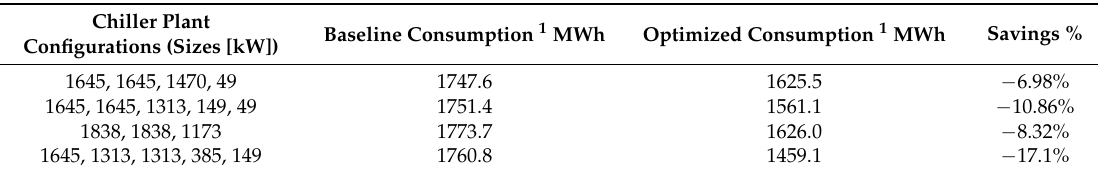
Table 2. Comparison of chiller energy consumptions and savings obtained using efficiency-based optimized control.